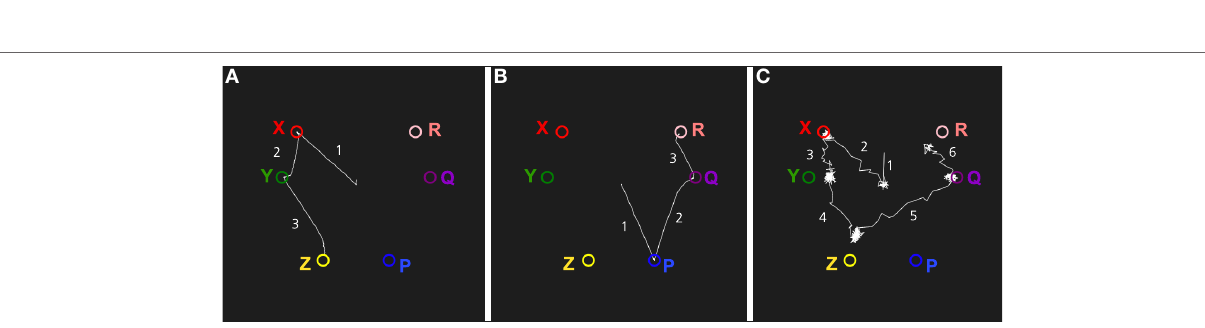
FigUre 8 | Simulation of mind wandering using semantic associations. (a) With low noise, the system will transition between semantically related states as a result of synaptic depression. (B) With a higher noise level, the memory system will transition less regularly and can potentially end up in semantically unrelated states. (c) With low synaptic depression, the system will move away from an attractor but return back again most of the